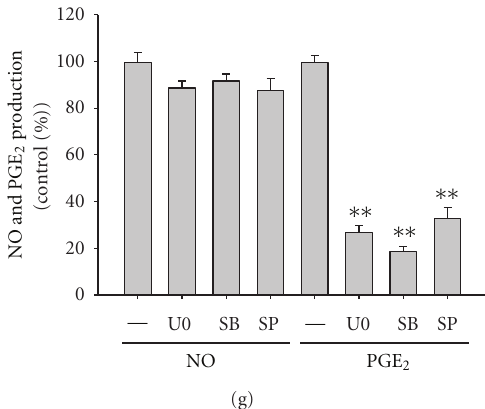
Figure 4: E ff ect of BAY on the activation of the AP-1 pathway. (a to d) HEK293 cells cotransfected with AP-1-Luc construct (1 μ g/mL) and β - gal (as a transfection control) were treated with BAY (0 to 20 μ M) in the presence or absence of PMA (100nM) or by cotransfection with AP-1 activation inducers (MyD88, TRIF, and TBK1). Luciferase activity was measured using a luminometer. (e) Translocated or phosphorylated levels of AP-1 family (c-Fos and c-Jun) from the nucleus from RAW264.7 cells treated with BAY (15 μ M) in the presence or absence of LPS (1 μ g/mL), evaluated by immunoblotting. (f) RAW264.7 cells (5 × 10 6 cells/mL) were incubated with BAY (15 μ M) in the presence or absence of LPS (1 μ g/mL) for indicated times. After preparing total lysates, levels of phospho (p)- or total proteins of JNK, p38, and ERK were identified by immunoprecipitation. (g) Levels of NO determined by the Griess assay and PGE2 by EIA from culture supernatants of RAW264.7 cell treated with U0126 (U0), SB203580 (SB), or SP600125 (SP) in the presence or absence of LPS (1 μ g/mL) for 24 h. ∗ P < 0 . 05 and ∗∗ P < 0 . 01 compared to the